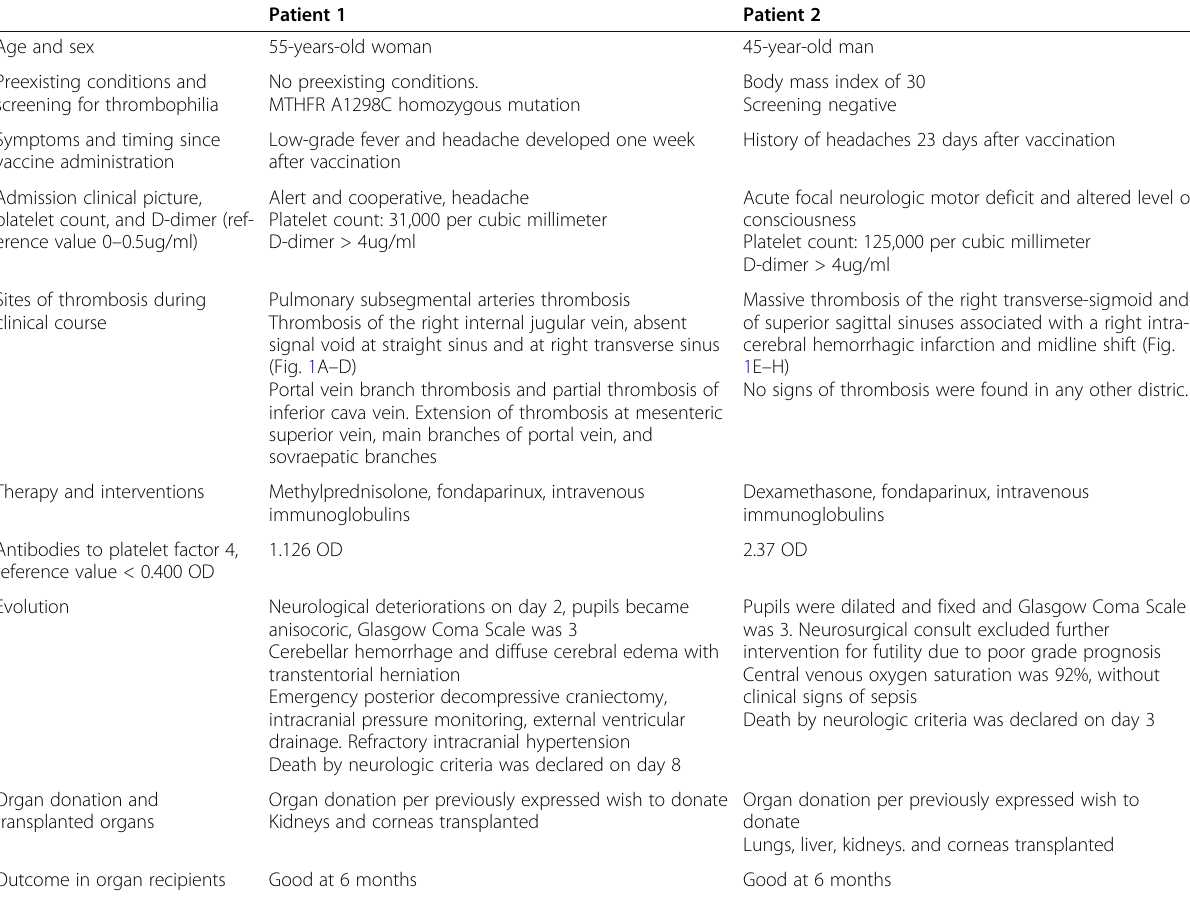
Table 1 Characteristics and clinical course of two cases of cerebral venous sinus thrombosis post vaccination with ChAdOx1